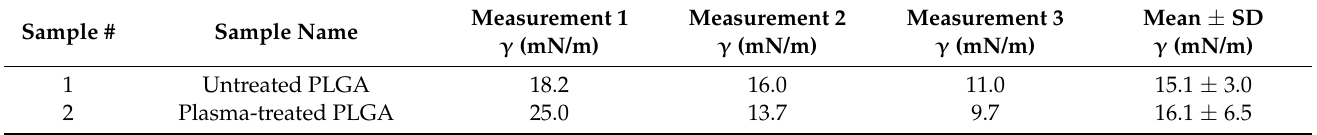
Table 4. Surface energy analysis of the solvent-cast PLGA samples via the Zisman method.